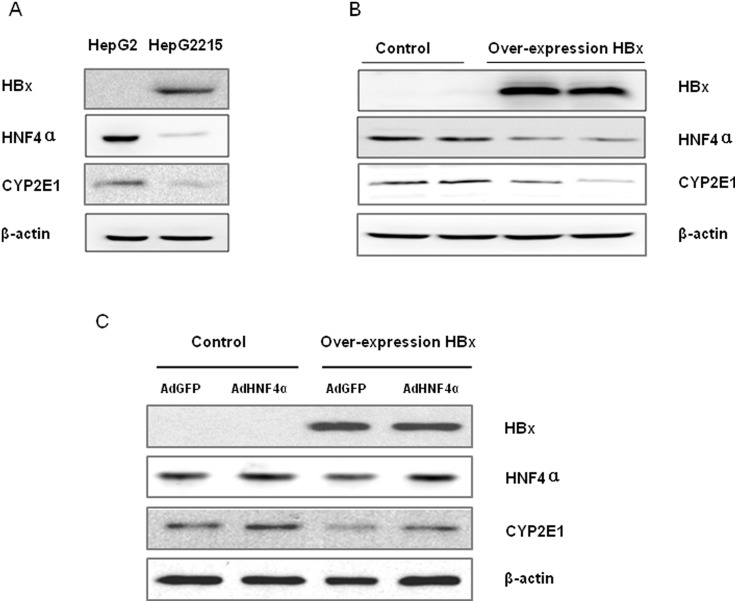
HBx inhibits CYP2E1 expression via downregulation of HNF4α.(A) HBV virus downregulated HNF4α and CYP2E1. HepG2215 cells, a cell line with the HBV genome integrated into the chromosome of HepG2 cells and capable of producing all HBV proteins, was used. Expression of HBx, CYP2E1 and HNF4α levels were measured with Western blotting. (B) Enforced expression of HBx protein downregulates CYP2E1 and HNF4α. HepG2 cells were transiently transfected with HBx-expression plasmid, and 24 hours post transfection, cells were harvested and cell lysate were used to determine HNF4α expression with Western Blotting. (C) HBx-induced CYP2E1 reduction could be rescued by HNF4α. HepG2 cells were transiently transfected with HBx-expression plasmid for 24 hours, then were infected with 1×109 plaque-forming units of AdHNF4α, or the same amount of AdGFP as control for one more day, respectively, in HepG2 cells. Cells were harvested and protein expression of HBx, CYP2E1 and HNF4α levels were measured with Western blotting.